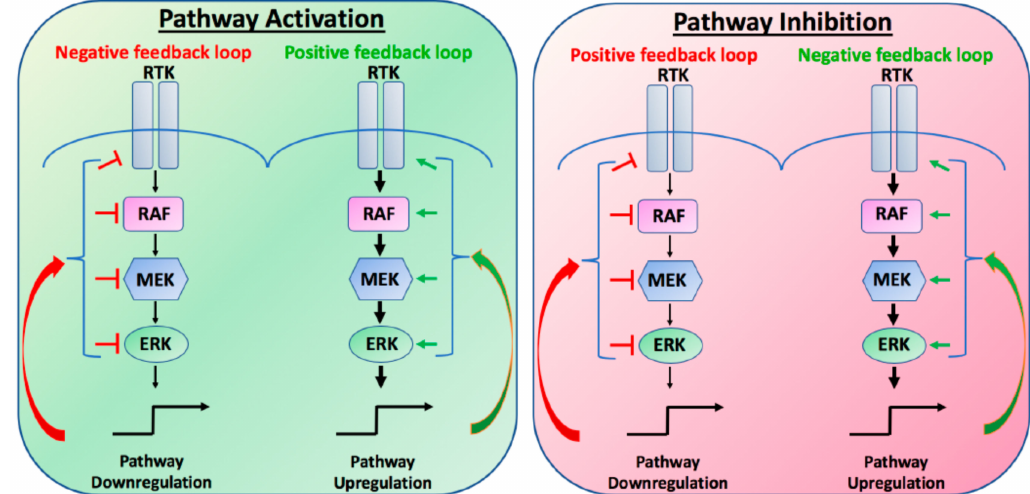
Figure 1. Schematic of positive and negative feedback loops in the canonical Mitogen-Activated Protein Kinase (MAPK) pathway. RTK, receptor tyrosine kinase; RAF, RAF proto oncogene; MEK, mitogen-activated protein kinase; ERK, extracellular signal-related